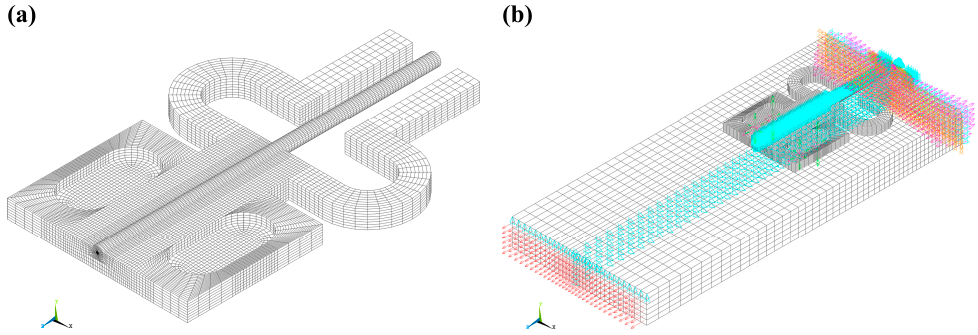
Figure 3. Three-dimensional (3-D) finite element (FE) model: ( a ) one half of a meshed model of a metal-packaged RFBG strain sensor, and ( b ) boundary conditions and applied